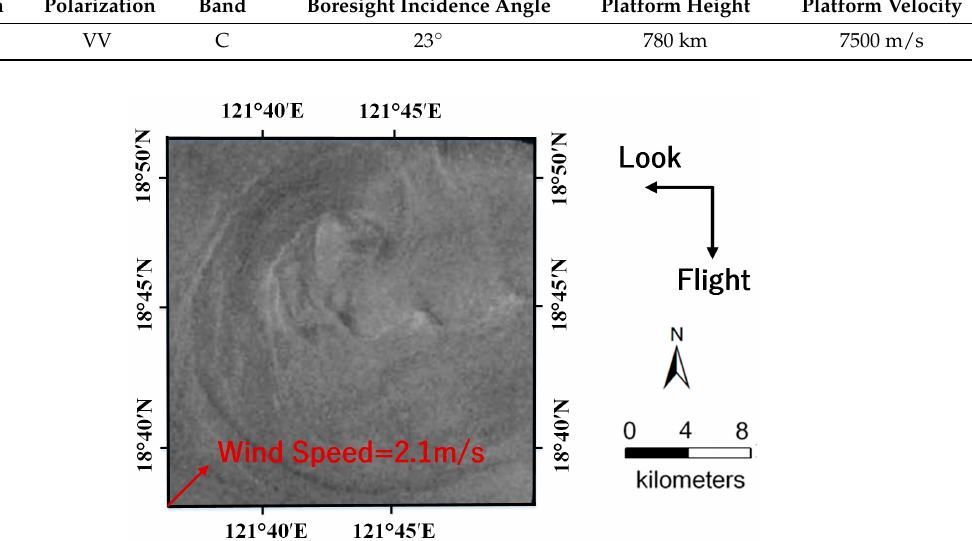
Figure 9. Enlargement of the shear-wave-generated eddy in Frame B. The flight and look direction of ERS-2 SAR are indicated by black arrows. The wind vector is shown as a red arrow.